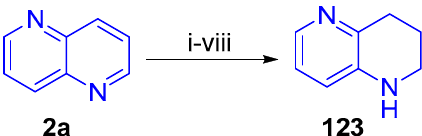
Scheme 47. Selective reduction of 1,5-naphthyridine to